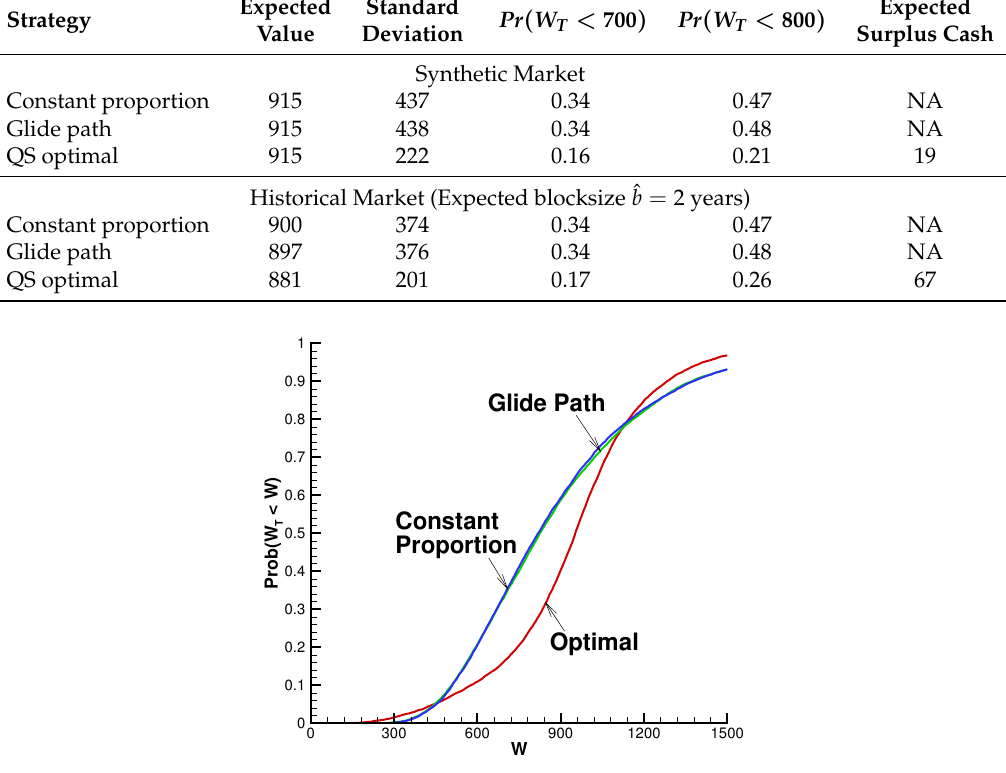
Figure 7. Cumulative distribution of real terminal wealth for QS optimal, glide path, and constant proportion strategies when the 10-year T-bond index is used. Wealth units: thousands of